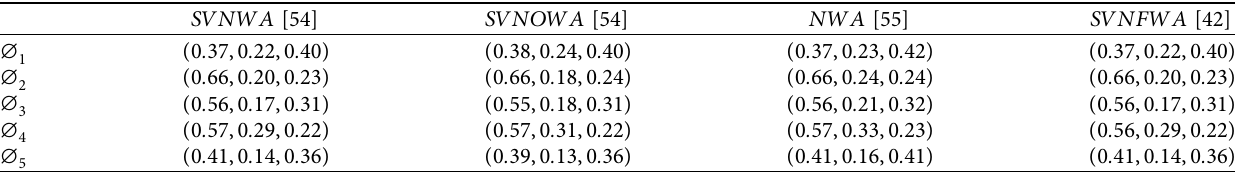
Table 7: Exisiting Aggregated SVN information.